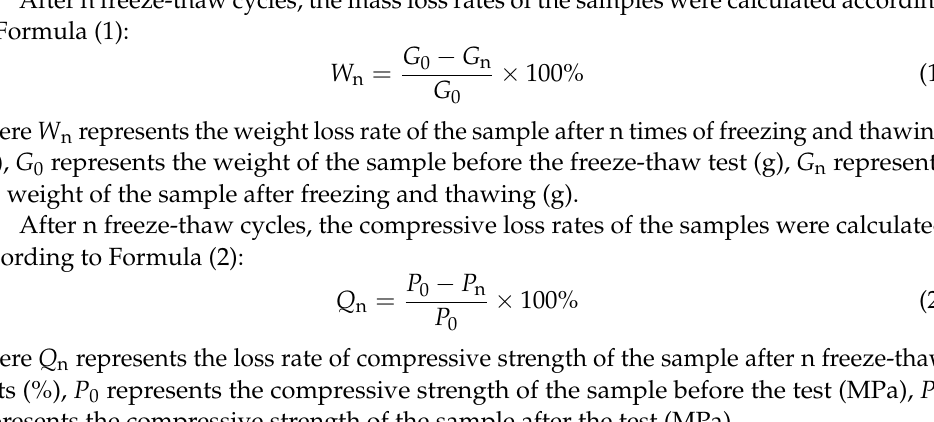
Figure 4. Samples and test details.